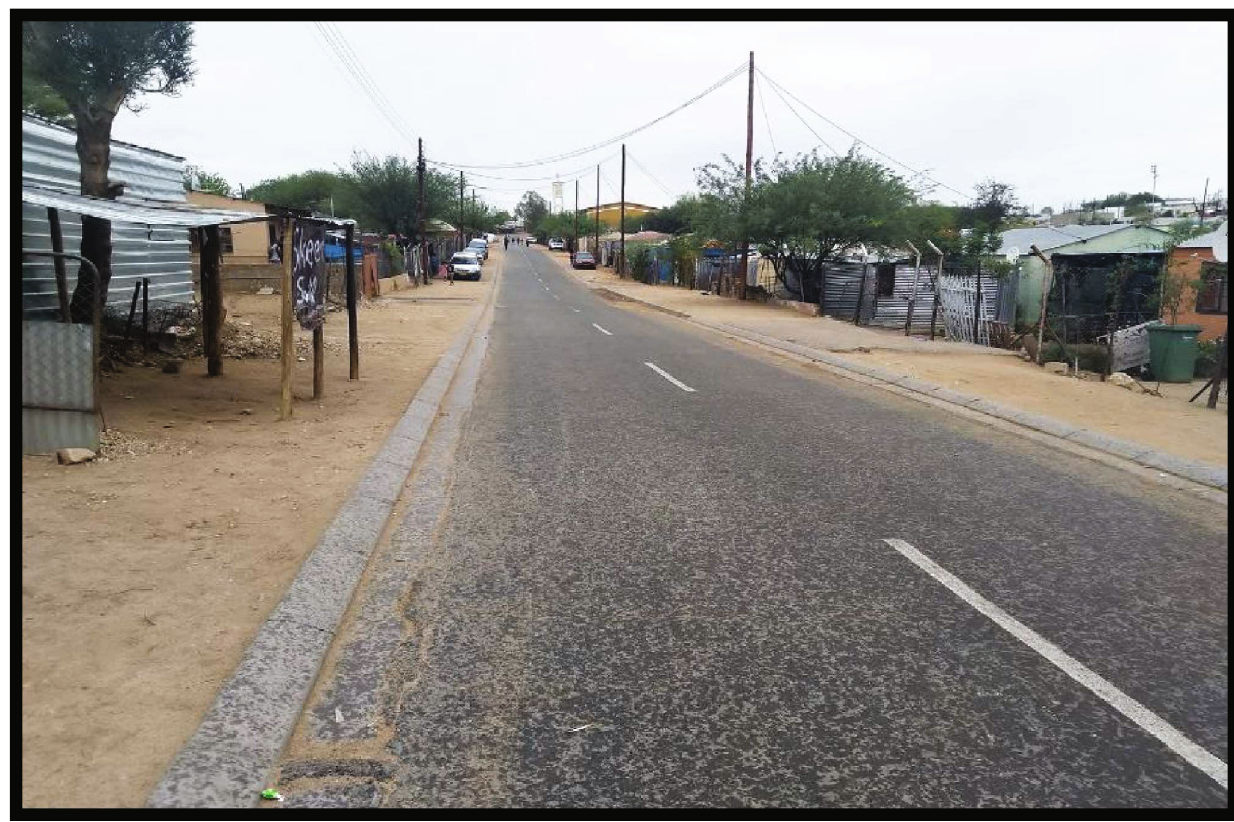
Figure 6: A picture illustrating unauthorised extended building/cars covering available space/sidewalks for wheelchair mobility (or no pavements for